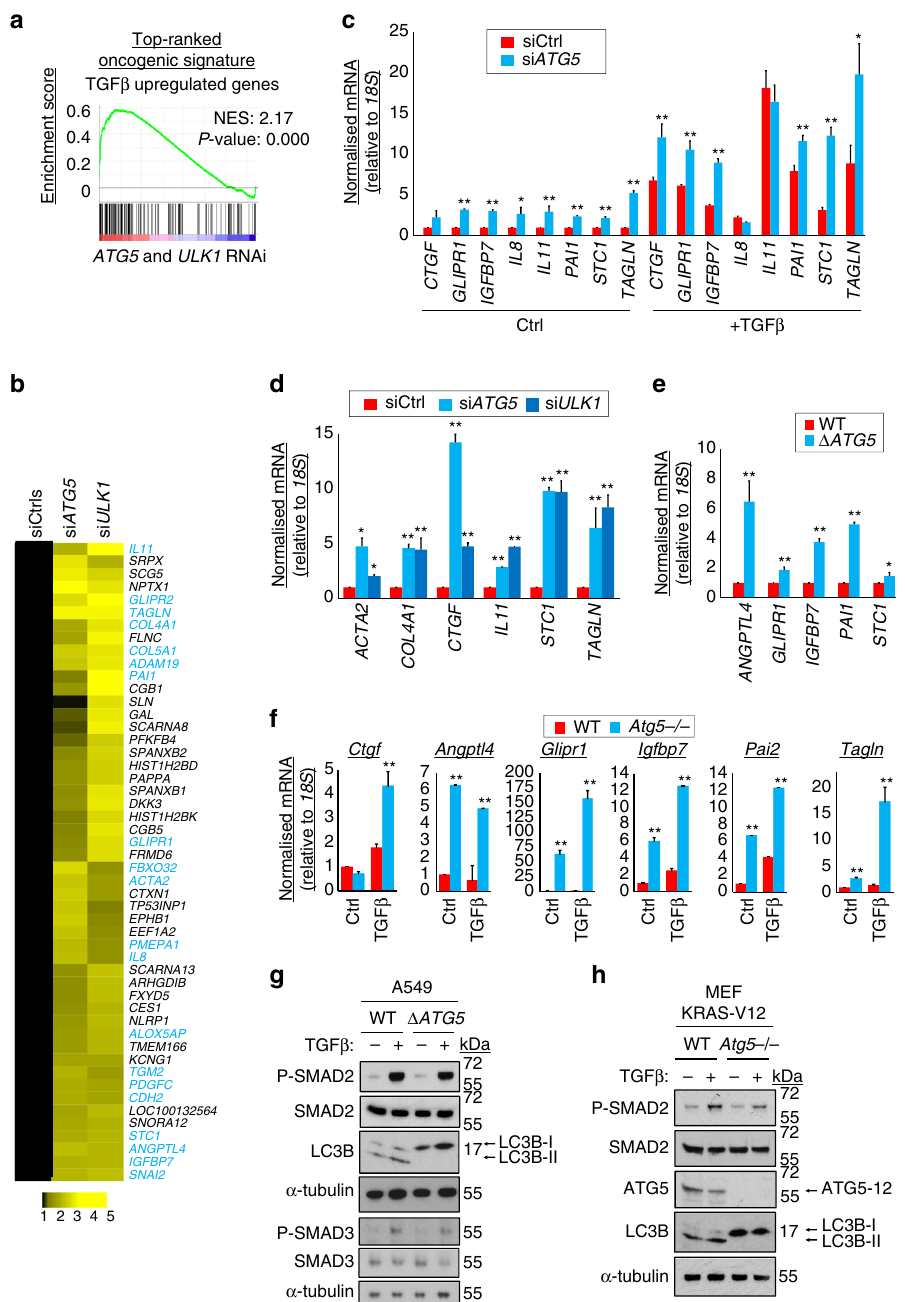
Fig. 2 Autophagy suppresses TGF β target gene expression. a siRNA oligonucleotides targeting ATG5 and ULK1 , or two sequence-unrelated non-targeting controls, were transfected in A549 cells in each of the three independent replicates. Expression pro fi les were obtained from an Illumina bead array, summarised in Supplementary Data set 1. Gene set enrichment analysis was performed, comparing genes differentially expressed in the autophagy inhibited cells with known oncogene- and tumour suppressor-driven expression pro fi les. The comparison yielding the greatest normalised enrichment score (NES), ‘ TGF β upregulated genes ’ , is shown here. b Fold-change heat map showing the top 50 upregulated genes after ATG5 and ULK1 RNAi. Mean si ATG5 or si ULK1 siRNA values are normalised to the averaged means of the two non-targeting controls (siCtrls). Blue text indicates genes that are known to be transcriptionally upregulated by TGF β (Supplementary Table 1). c – f qRT-PCR was performed for the indicated transcripts after the following treatment regimens. c A549 cells were transfected with siCtrl or si ATG5 for 72 h. Cells were either left untreated (Ctrl) or treated with 5 ng/ml TGF β 1 for the fi nal 16 h of transfection. d A549 cells were transfected with siCtrl, si ATG5 or si ULK1 for 72 h. e Exponentially dividing A549 WT and Δ ATG5 cells were compared. f Congenic wild-type ( WT ) or Atg5 null ( Atg5 − / − ) MEF KRAS-V12 cells were left untreated (Ctrl) or treated with 5 ng/ml TGF β 1 for 16 h (means, n = 3, ± S.D., * P < 0.05 or ** P < 0.01 vs. siCtrl or similarly treated WT cells, two-tailed t -test). g A549 WT and Δ ATG5 cells and h WT and Atg5 − / − MEF KRAS-V12 cells, with (+) or without ( − ) prior treatment with 5 ng/ml TGF β 1 for 16 h, were lysed and immunoblotted (P-SMAD2 = phospho-S465/ 467 SMAD2, P-SMAD3 = phospho-S423/425 SMAD3). Uncropped blots are available in Supplementary Fig.